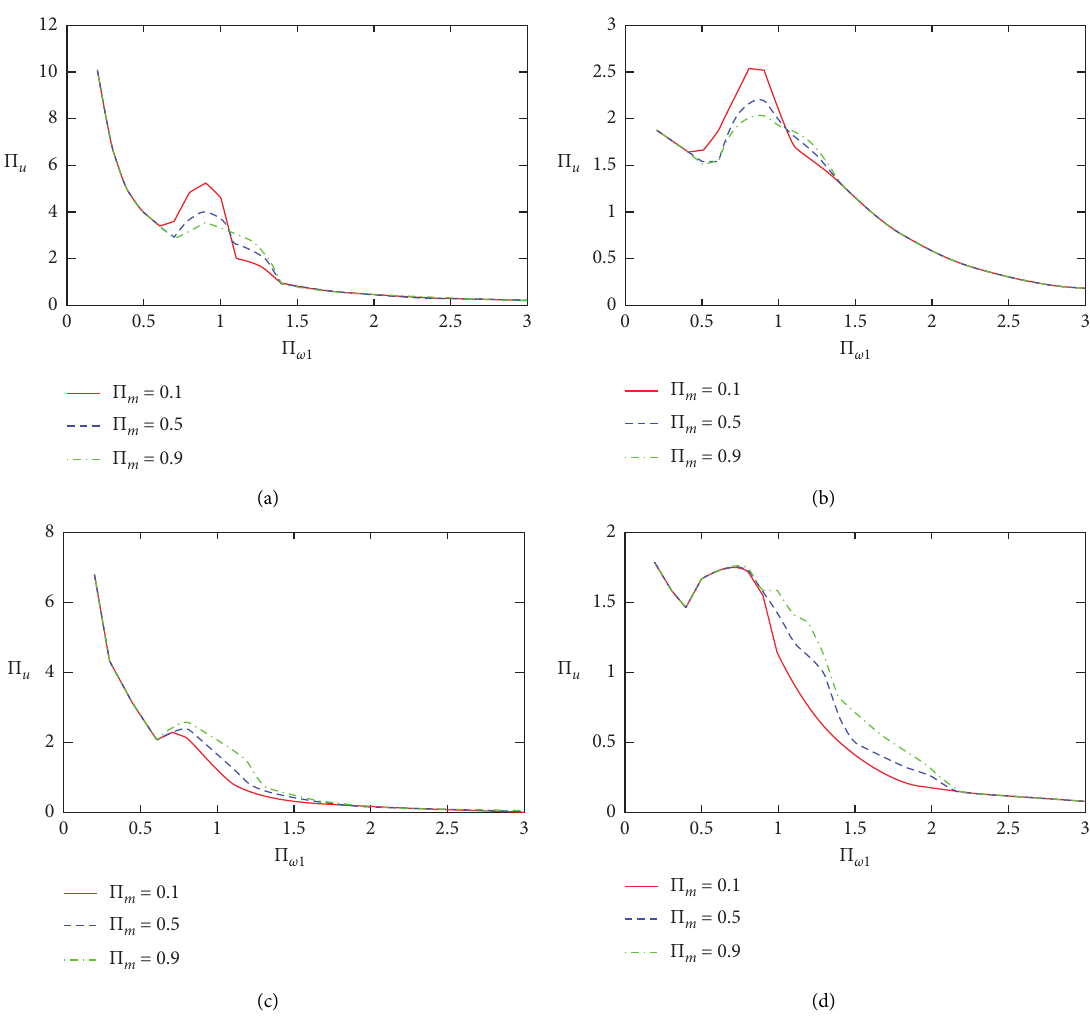
Figure 8: Maximum dimensionless displacement Π u and velocity Π v versus Π ω 1 for various structural spacing Π d ( Π m � 0 . 9, Π � 0 . 8, Π � 0 . 9, μ � 1 . 5, Π � 0 . 1, Π � 50, and Π � 0 . 4). (a) Maximum dimensionless displacement Π Π uy uy 2 uy 1 r 1 α ω con structure. (b) Maximum dimensionless velocity Π v of left-side structure. (c) Maximum dimensionless displacement Π u of right-side structure. (d) Maximum dimensionless velocity Π v of right-side